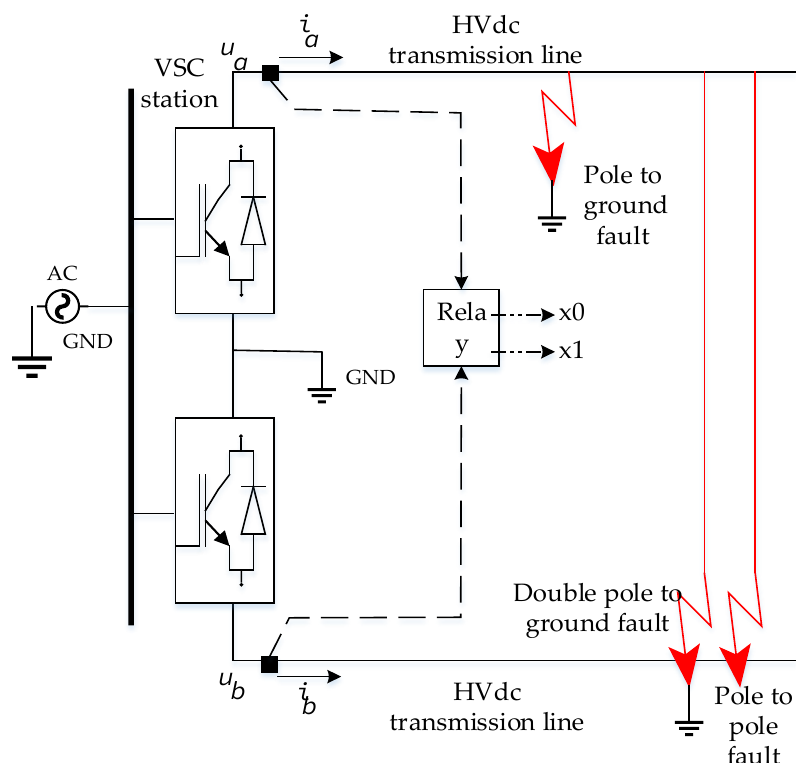
Figure 14. Protective relaying signal for high-voltage direct current (HVdc) link under faulty conditions.